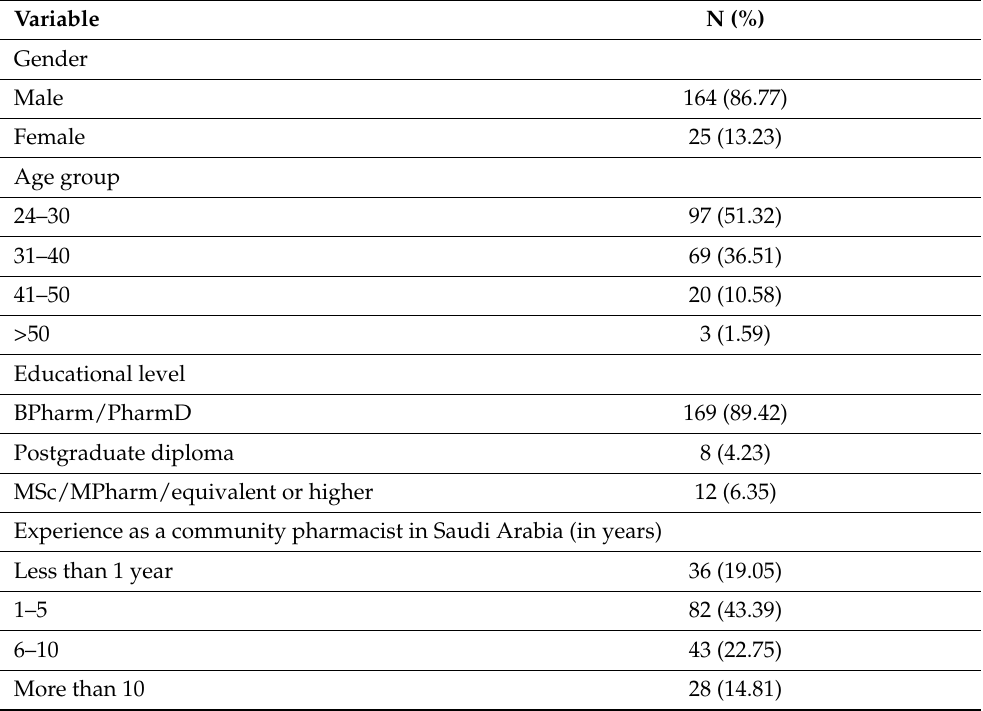
Table 1. Sociodemographic data of the